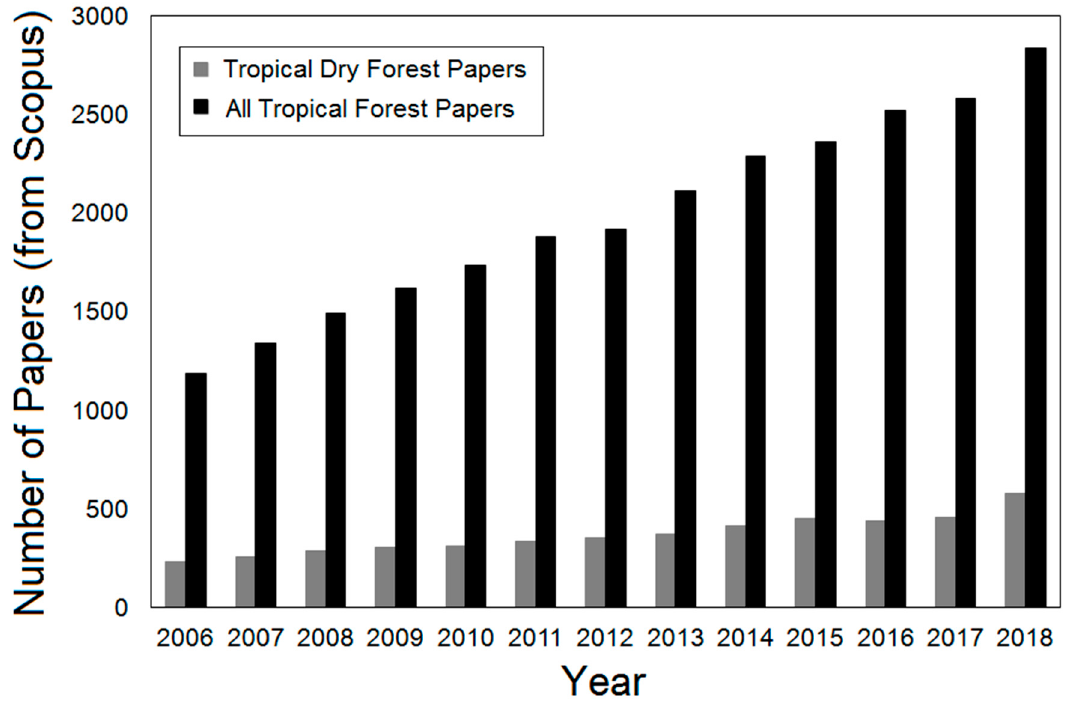
Figure 2. The number of papers on tropical forests and TDFs annually from 2006 to 2018 based on Scopus search results.